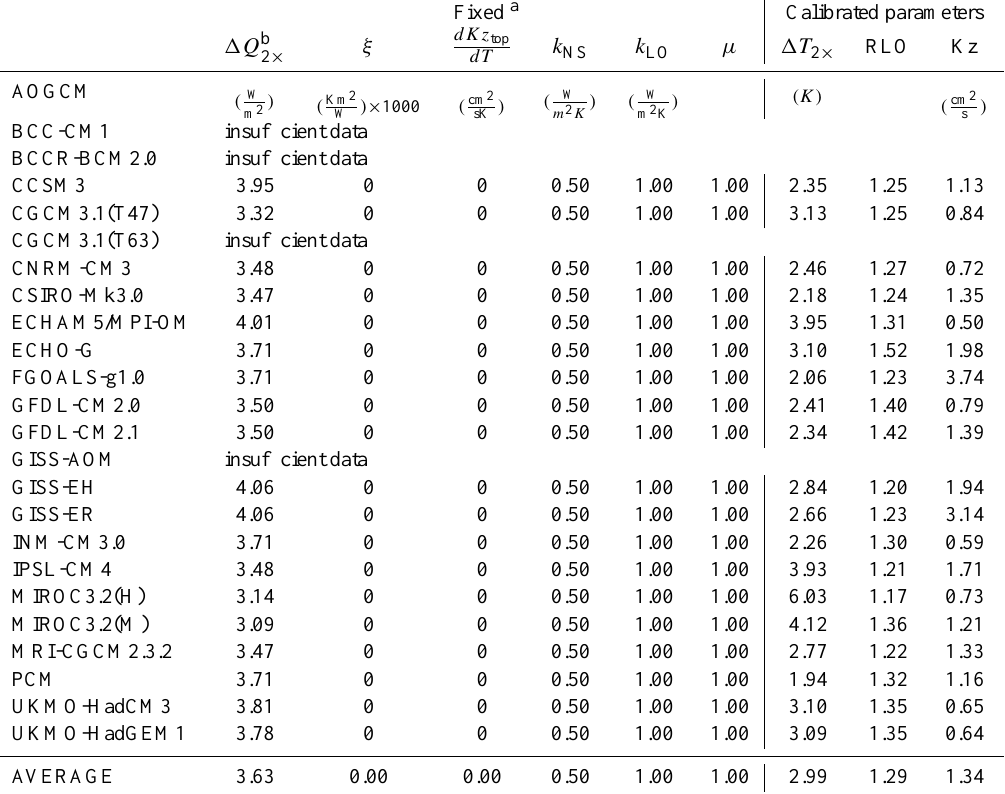
Table B1. AOGCM calibration I results: MAGICC6 parameters required to emulate CMIP3 AOGCM models using idealized scenarios and three calibrated parameters only. See Table